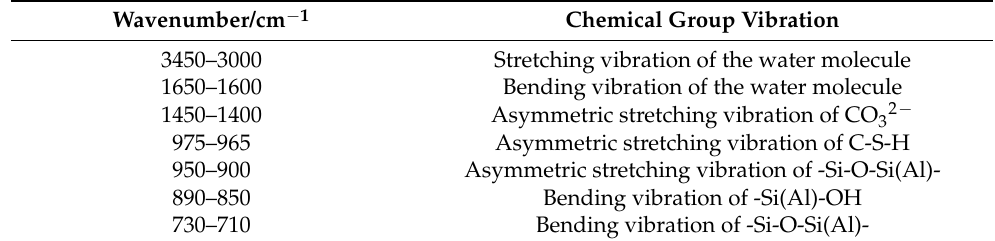
Table 3. Various absorption bands corresponding with chemical group vibrations [20,21].